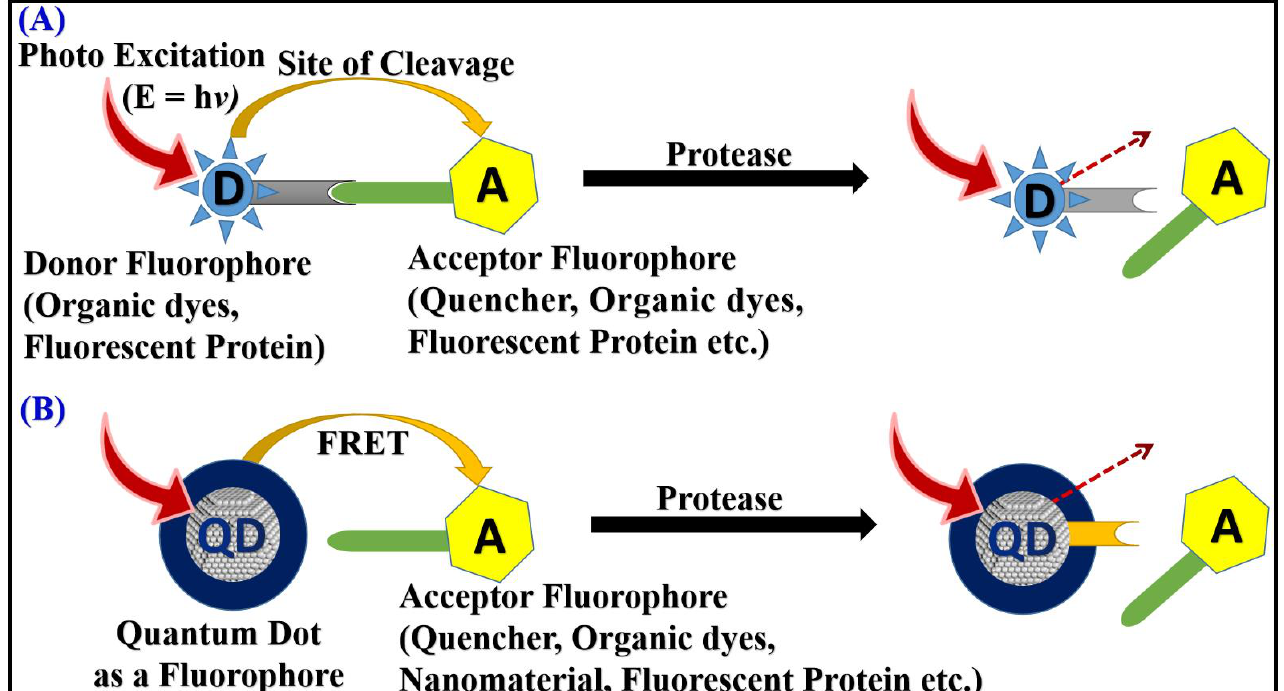
Figure 4. Protease activity detection using FRET: ( A ) old and conventional approach; ( B ) FRET based on fluorescent QDs.